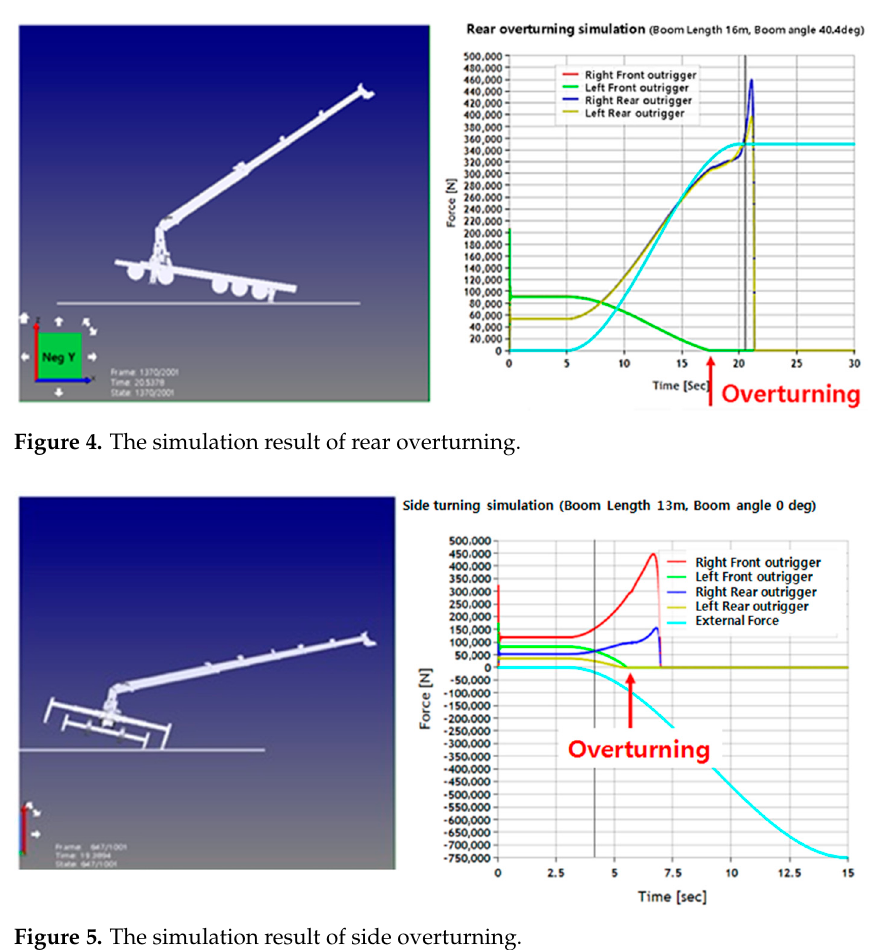
Figure 5. The simulation result of side overturning.